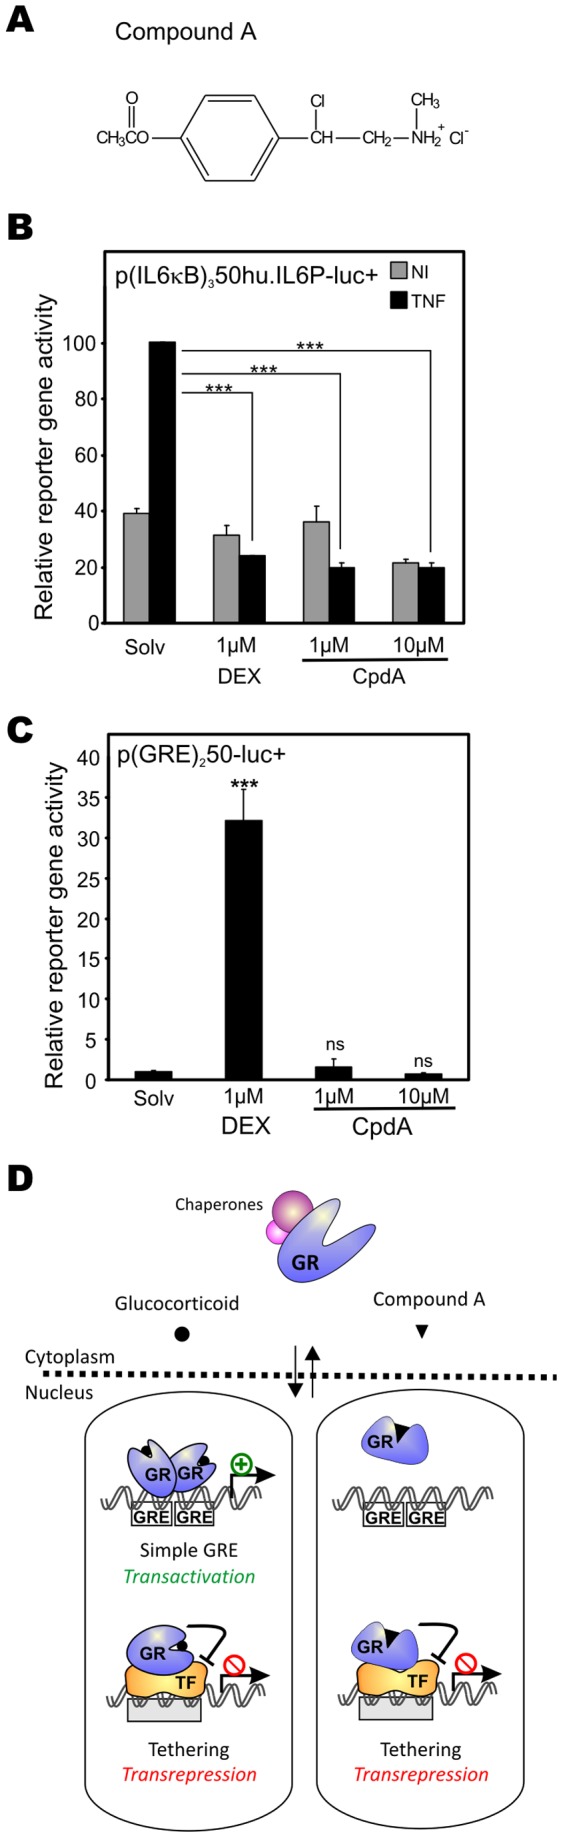
Compound A is a selective GR modulator with NF-κB repressive capacity.(A) Compound A chemical structure (B) A549 cells, transiently transfected with p(IL6κB)350hu.IL6P-luc+, were treated with solvent (Solv), DEX (1µM) or CpdA (1µM or 10µM) for 2h. Subsequently, cells were induced with TNF (2000 IU/ml) for 6h where indicated. β-gal control-corrected results were presented as relative reporter gene activity with the condition Solv/TNF set at 100. Statistical analysis (ANOVA with Tukey’s multiple comparison post test) was performed to show significant difference with the TNF condition for selected conditions (*** p<0.001). (C) A549 cells, transiently transfected with p(GRE)250-luc+, were treated with Solv, DEX (1µM) or CpdA (1µM or 10µM) for 8h. β-gal control-corrected results were presented as relative reporter gene activity with the condition Solv set at 1. Statistical analysis (ANOVA with Tukey’s multiple comparison post test) was performed to show significant difference with the Solv condition (ns not significant; *** p<0.001). Results are shown +/−SD. Figures in (B) and (C) are representative of at least 3 independent experiments. (D) Schematic model of gene modulatory GC and CpdA effects. While classic GCs can transactivate GRE-regulated genes and impede gene expression of specific target genes via a tethering transrepression mechanism (left panel), CpdA drives GR into a monomer formation that does not allow transcactivation of GRE-regulated gene expression. CpdA liganded GR can, however, still repress gene expression via transrepression (right panel).